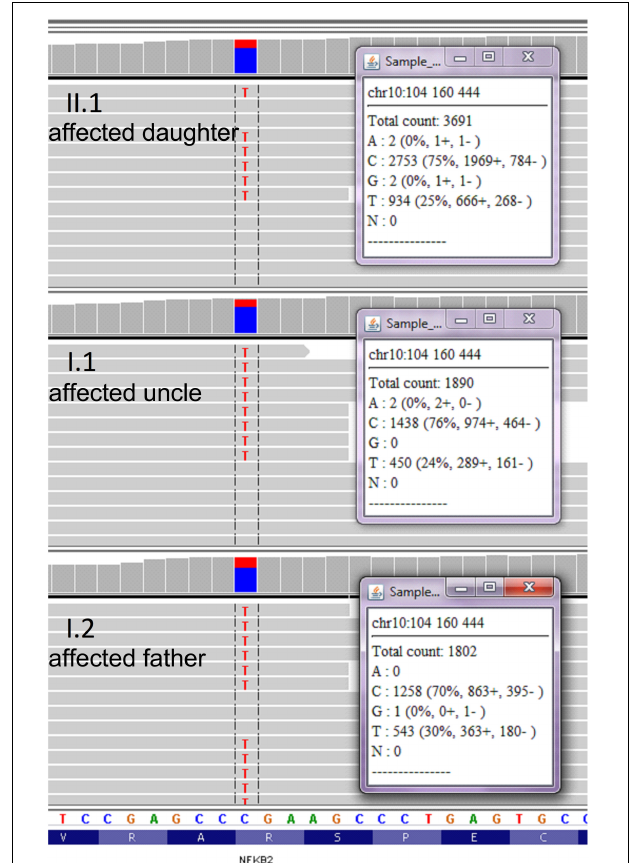
FIGURE 2 | Analysis of wild type and mutated NFKB2 transcripts. RNA isolated from leukocytes was used for cDNA synthesis. Sanger sequencing was performed on cDNA product generated after PCR over the c.1831 position. Wild-type and mutated transcripts were detected in all individuals characterized by c.1831C > T